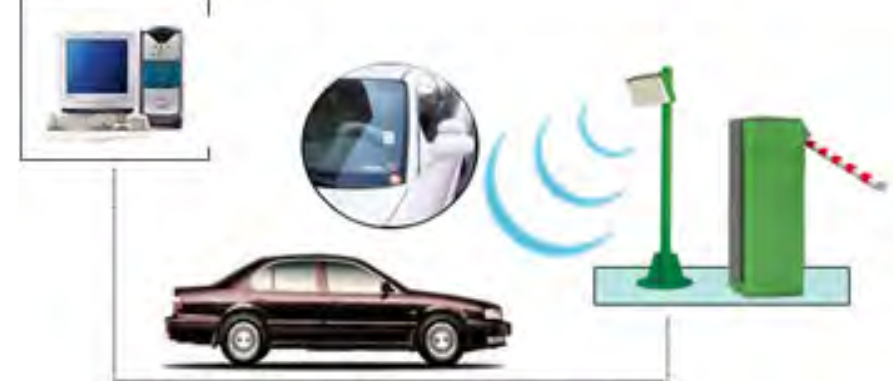
Figure 7. Advanced payment systems for managing the payment of parking fees (Smith,2012).